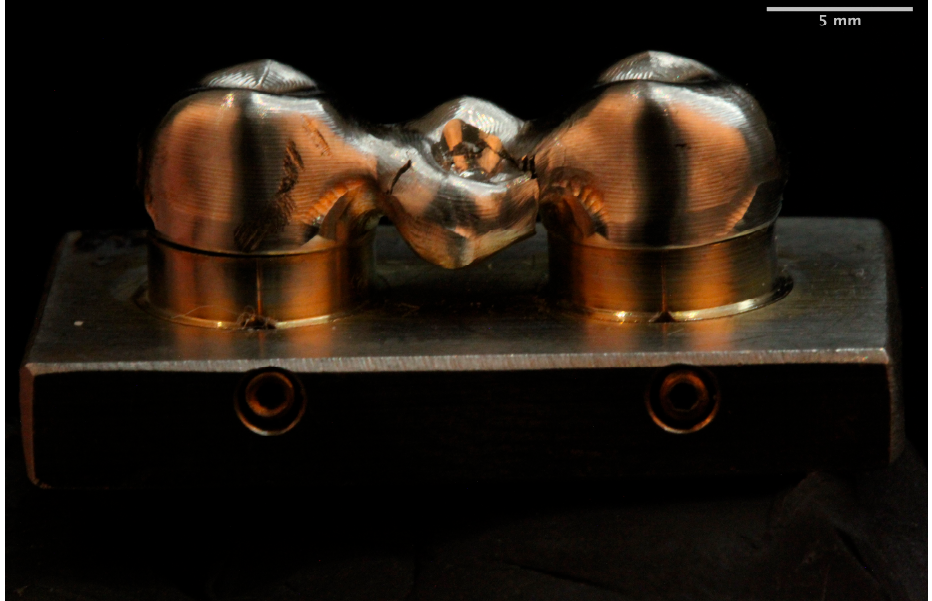
Figure 3. Milled metal framework fracture.